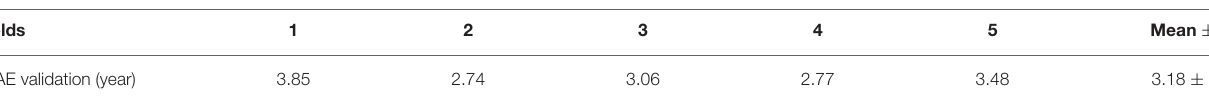
TABLE 2 | Model performance on cross-validation datasets. Folds